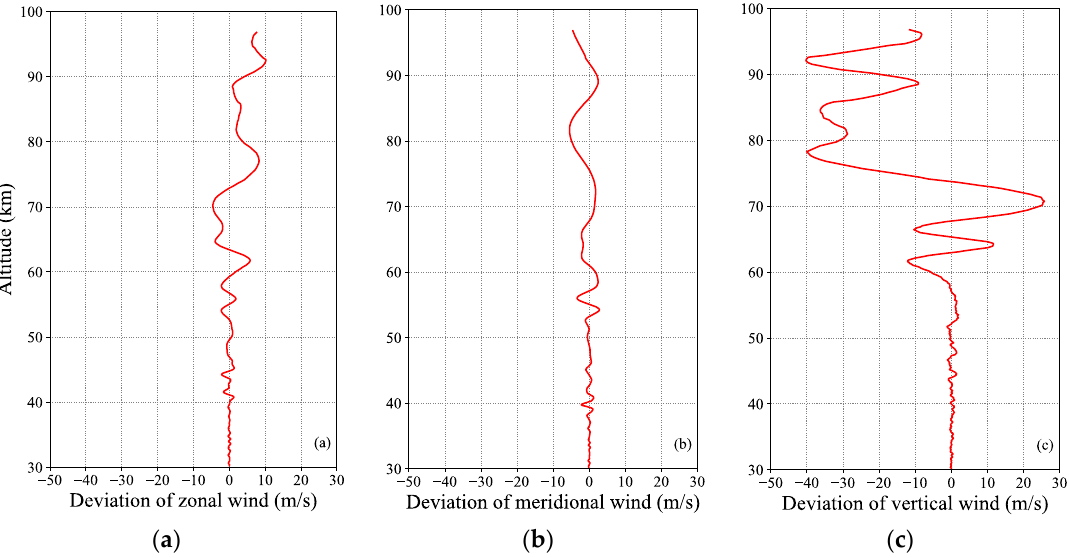
Figure 7. Deviation of the retrieved three-dimensional wind field. ( a ) Deviation of the zonal wind; ( b ) deviation of the meridional wind; ( c ) deviation of the vertical wind.